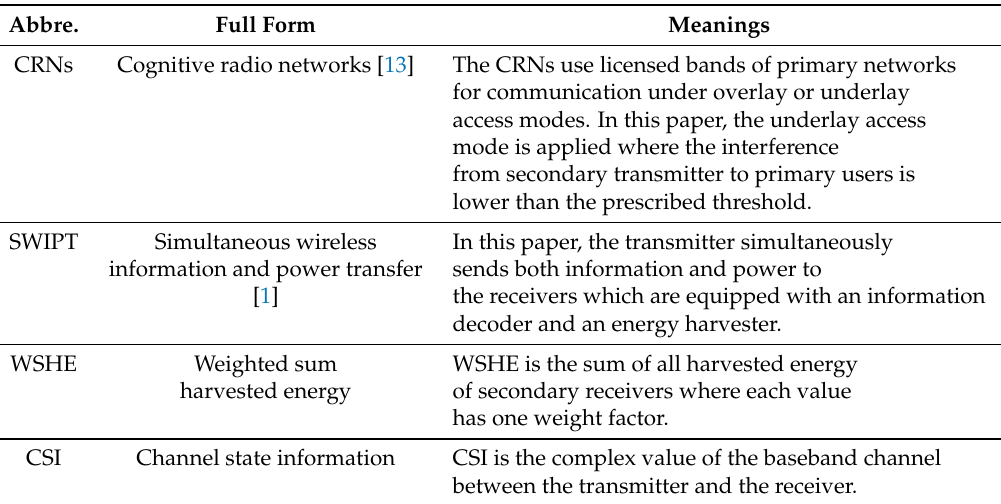
Table 1. Abbreviations and